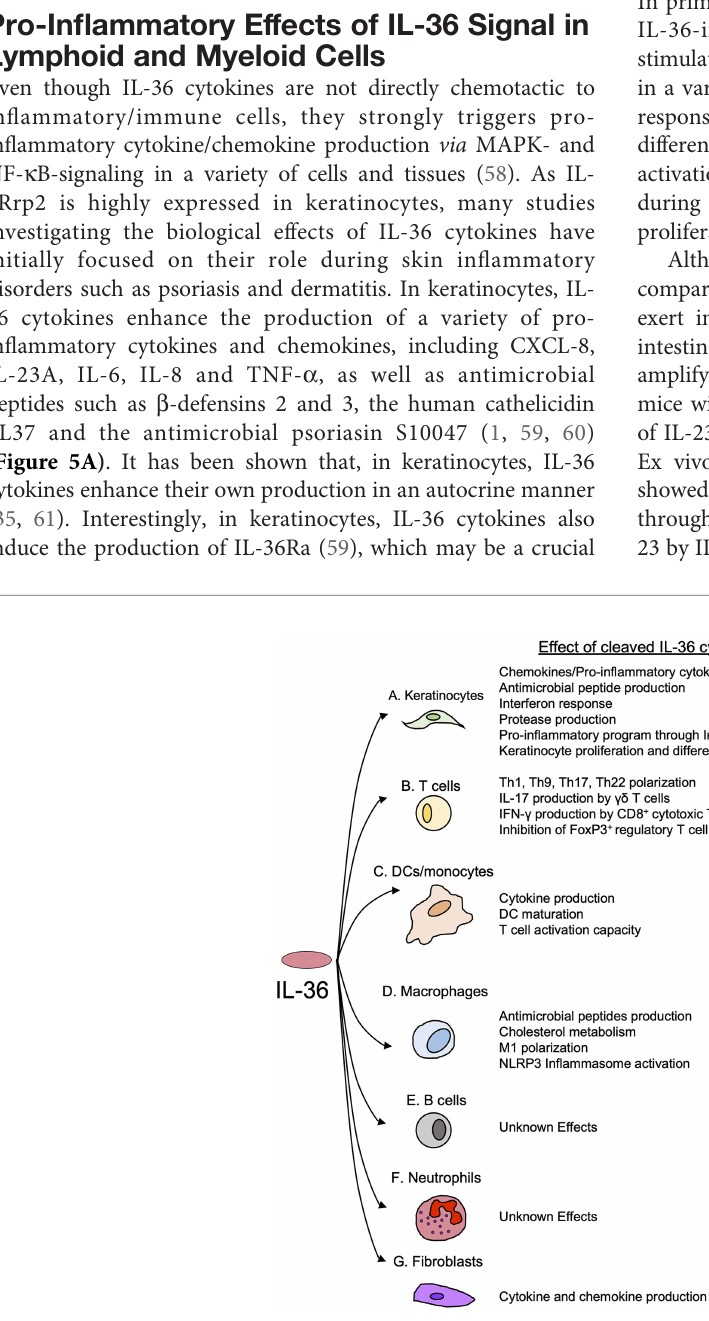
FIGURE 5 | The effects of cleaved IL-36 cytokines on keratinocytes and immune cells. IL-36 cytokines trigger the activation of several in fl ammatory processes in (A) keratinocytes and various immune cells, including (B) T cells, (C) DCs and monocytes and (D) macrophages. (E) B cells and (F) neutrophils are known to express IL- 1Rrp2, but the effects of IL-36 cytokines on their function have not yet been determined. Finally, IL-36 cytokines have shown to induce the production of pro- in fl ammatory cytokines in (G) fi